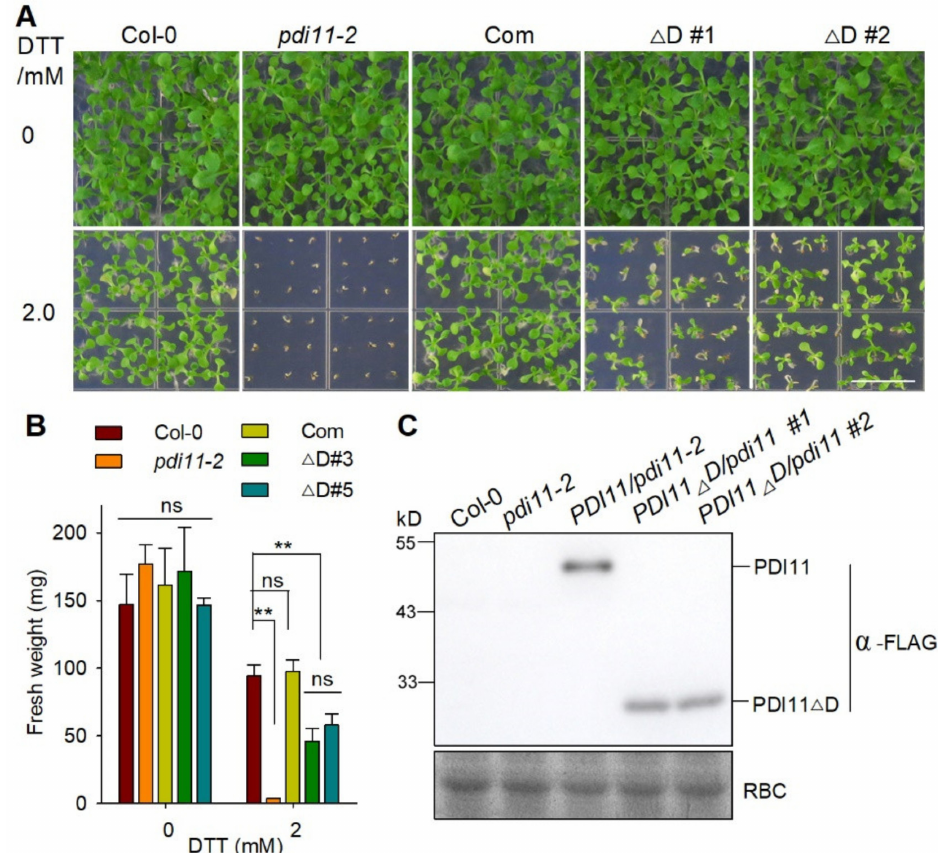
Figure 7. The D domain is required for AtPDI11 (cid:48) s function under reducing conditions. ( A ) The growth phenotype of AtPDI11 ∆ D gene expressing in pdi11-2 mutant transgenic plant. Col-0, pdi11-2 , Com, and proPDI11::PDI11 ∆ D seedlings were grown on medium with or without 2.0 mM DTT for 2 weeks. Bar = 1 cm. ( B ) Statistical analyses of the fresh weight of plants presented in ( B ). Values are shown as means ± SE from three independent biology repeats ( n = 36). Statistical significance compared to Col-0 was determined by one-way ANOVA. ** p < 0.01; ns, not significant. ( C ) The expression of AtPDI11-FLAG and AtPDI11 ∆ D -FLAG transgenic plants in pdi11-2 background. The expression proteins were detected by Western blotting with an anti-FLAG antibody. Rubisco (RBC) stained with Coomassie blue shows roughly equal